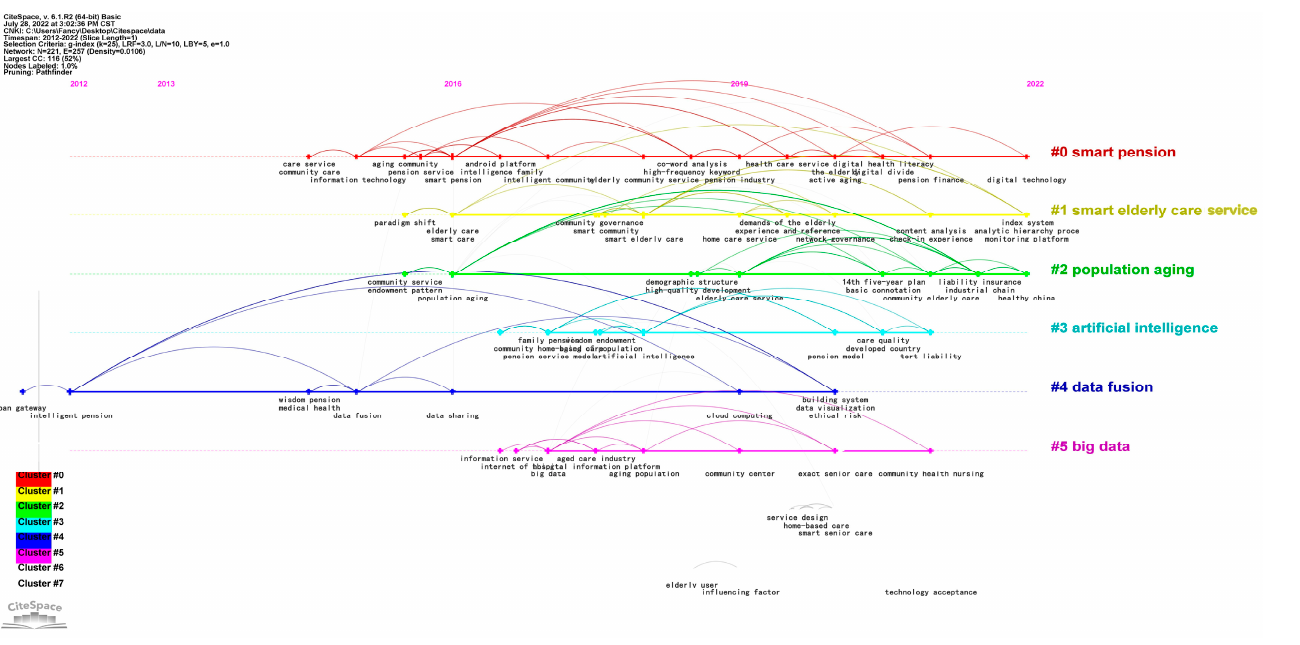
Figure 9. The research timeline of smart elderly care from CNKI.